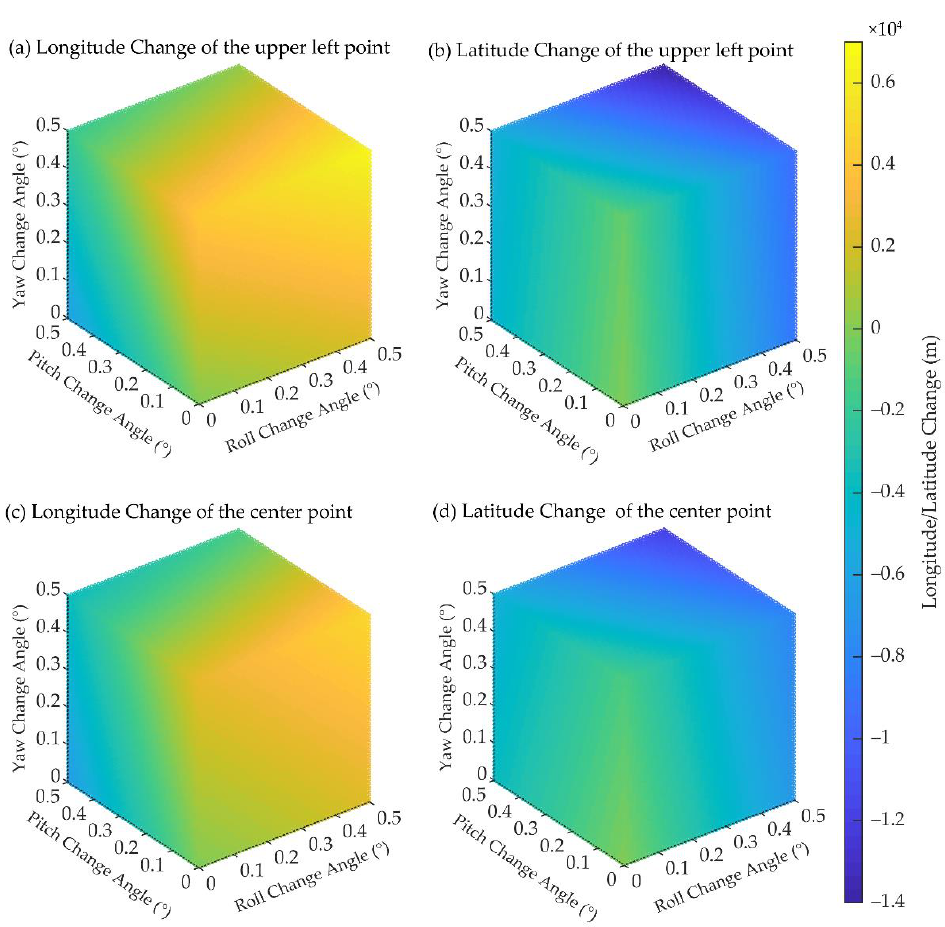
Figure 5. Three-dimensional scatter diagram of the influence of the satellite ’ s attitude angle change on the geolocation change. ( a , b ) show the impact of the satellite’s attitude changes on the longitude change and the latitude change of the upper left corner point of the image, respectively. ( c , d ) show th e impact of the satellite’s attitude changes on the longitude change and the latitude change of the center point of the image, respectively. The color of the scatters represents the longitude/latitude change according to the legend.